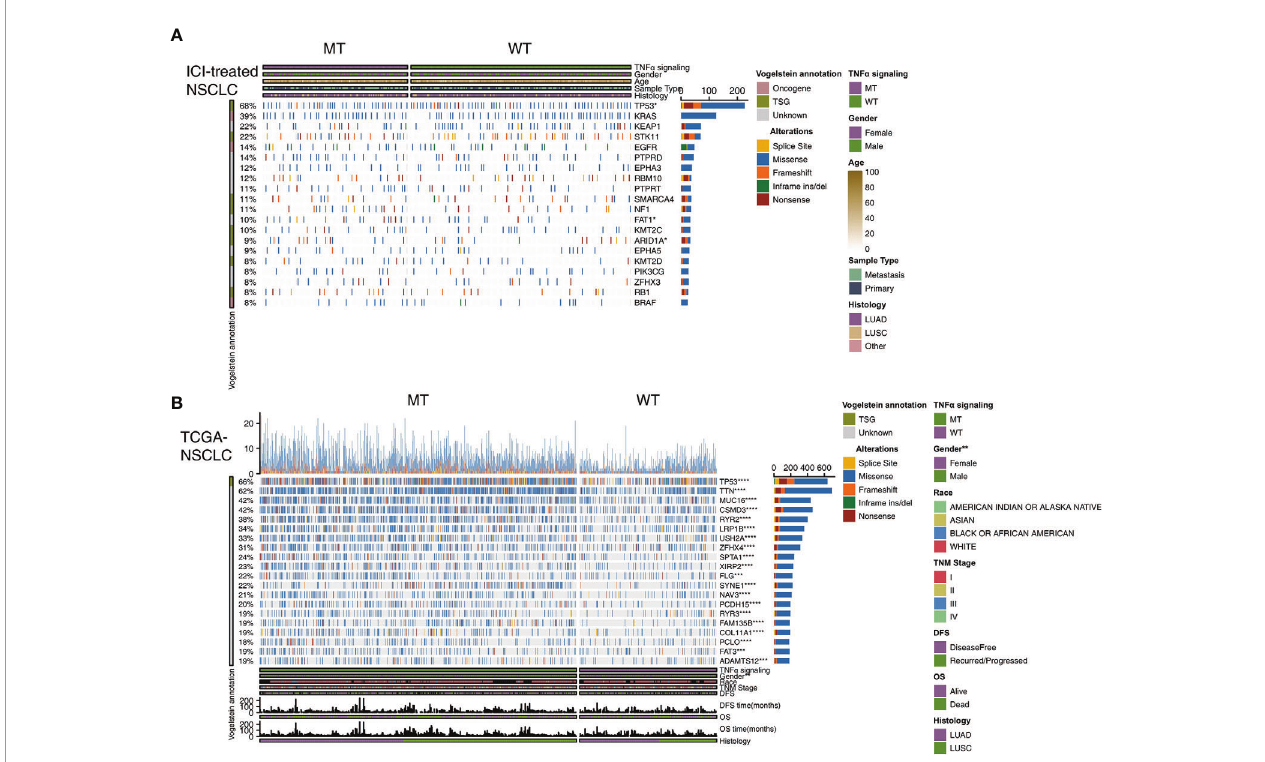
FIGURE 2 | Genomic pro fi les of NSCLC patients in the ICI-treated (A) and TCGA-NSCLC (B) cohorts. The top 20 genes with the highest mutation frequencies and the corresponding clinical information are shown in the fi gure. (*P < 0.05; **P < 0.01; ***P < 0.001; and ****P < 0.0001; Fisher ’ s exact test). NSCLC, non small-cell lung cancer; TCGA, The Cancer Genome Atlas; ICI, immune checkpoint